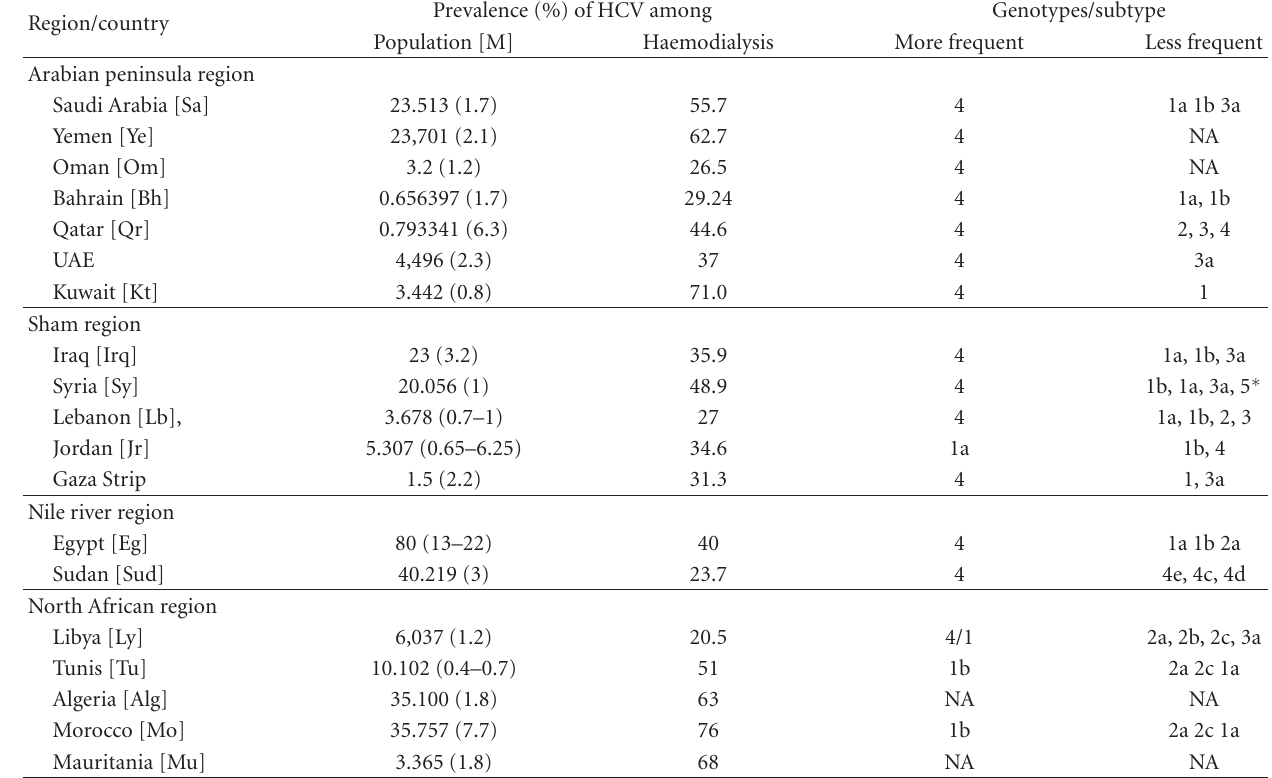
Table 1: Prevalence of hepatitis C virus and its common genotypes among Arab